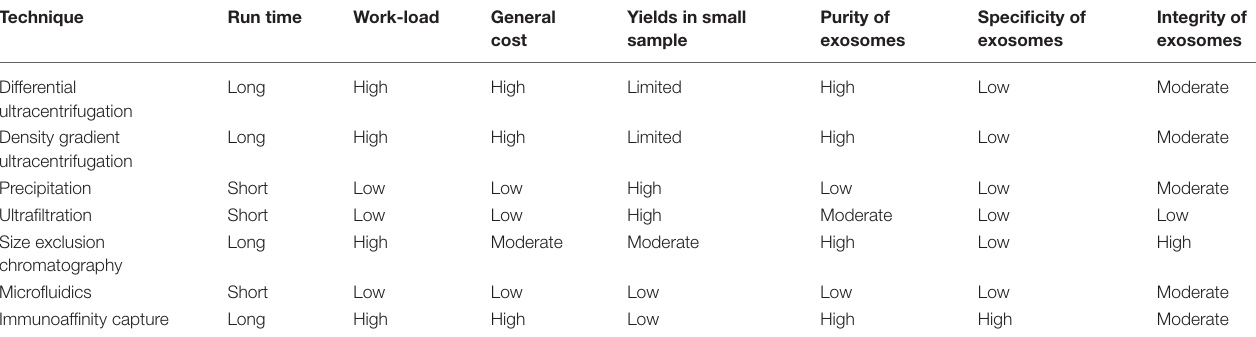
TABLE 1 | Relative comparison of different techniques for isolation of exosomes.